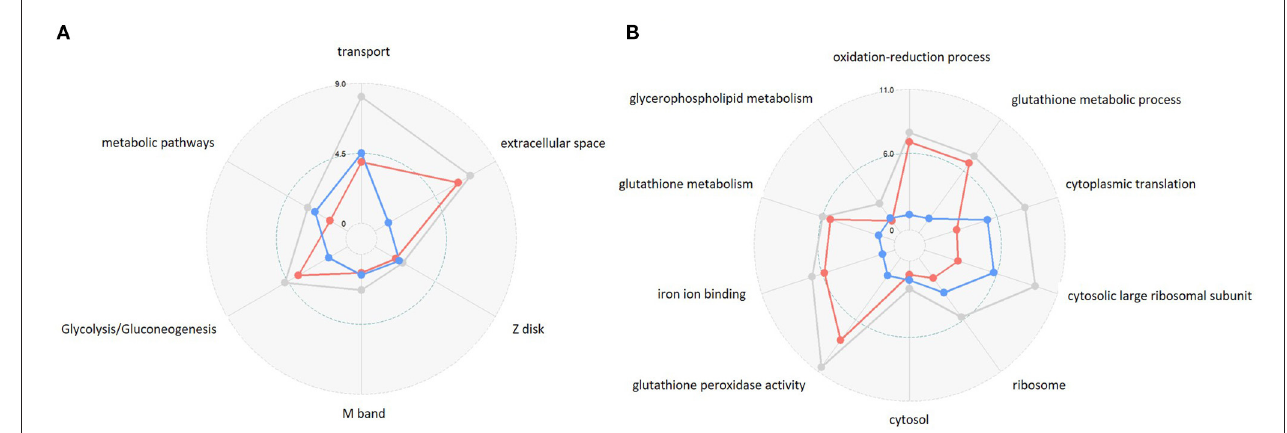
FIGURE 2 | Comparison of the top GO terms that are enriched in DE genes in the WT strain. GO terms are compared by their p -values; the centers of the circles correspond to –log10(p) = 0, which increases outwards. (A) Downregulated genes; (B) upregulated genes. Gray: all DE genes in WT (these correspond to the 717 DE transcripts in Figure 1E , gray circle); red: DE genes that are shared between WT and DAT mutant (these correspond to the 409 transcripts depicted in red in Figures 1E,F ); blue: DE genes that are unique to WT and not shared with DAT mutant (these correspond to the 308 transcripts depicted in blue in Figures 1E,F ). The diagrams were created using the R package ggradar (